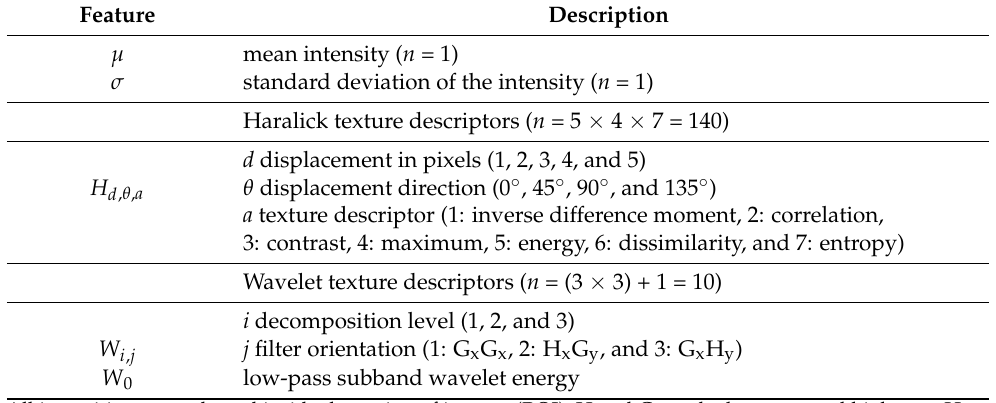
Table 1. A list of 152 texture features and their